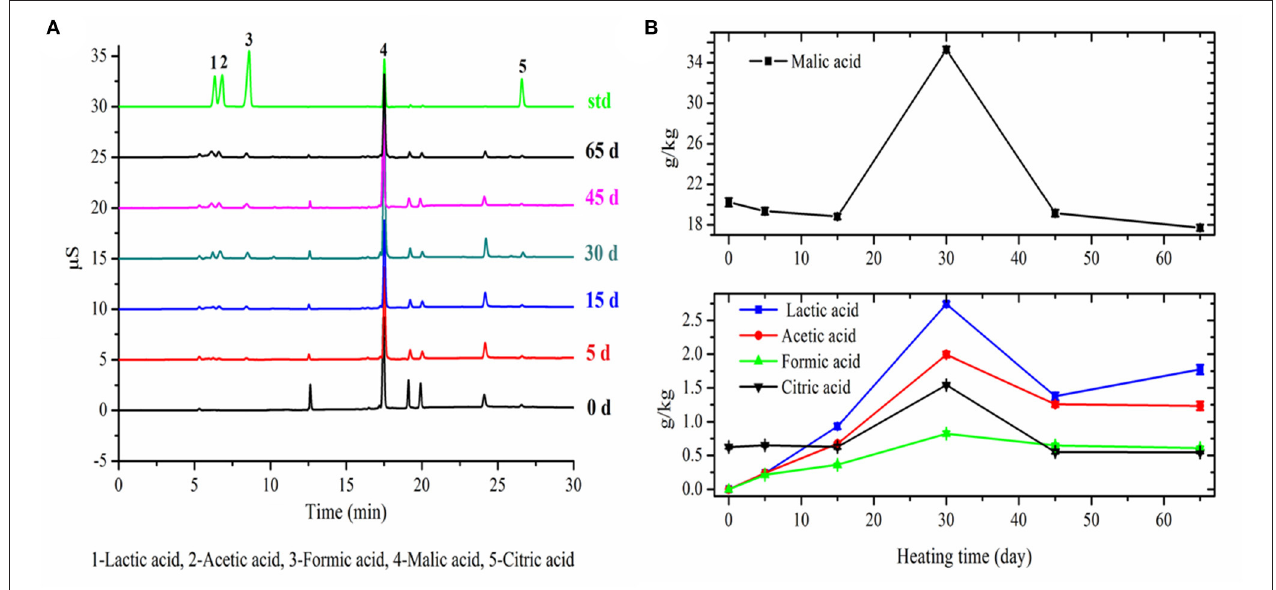
FIGURE 3 | Chromatograms of organic aids in apple samples with different fermentation days (A) and changes in organic aids of apple during 65-day HTFP process (B) .